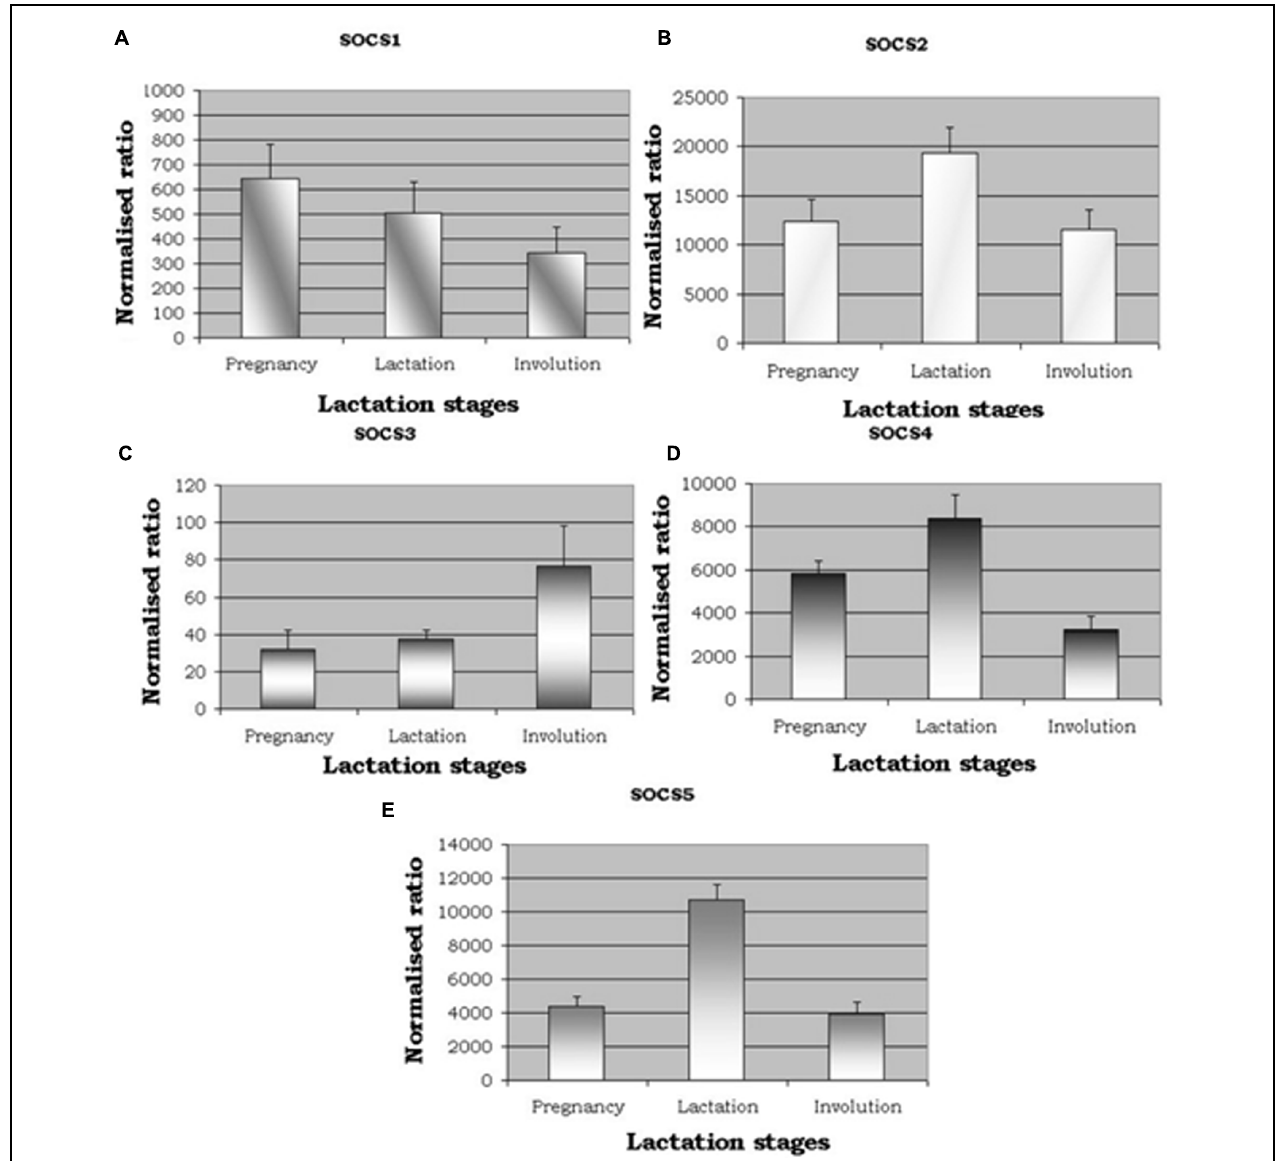
FIGURE 1 | qRT-PCR expression for suppressors of cytokine signalling ( SOCS) . (A–E) show expression of SOCS 1, SOCS 2 , SOCS 3 , SOCS 4, and SOCS 5. Normalized ratios showing altered expression for five members of SOCS genes across the three distinct lactation stages, namely pregnancy, lactation, and involution. P -values were significant between lactation stages for [ SOCS2 , P = 0.057 (suggestive); SOCS4 , P = 0.007); SOCS5 , P <